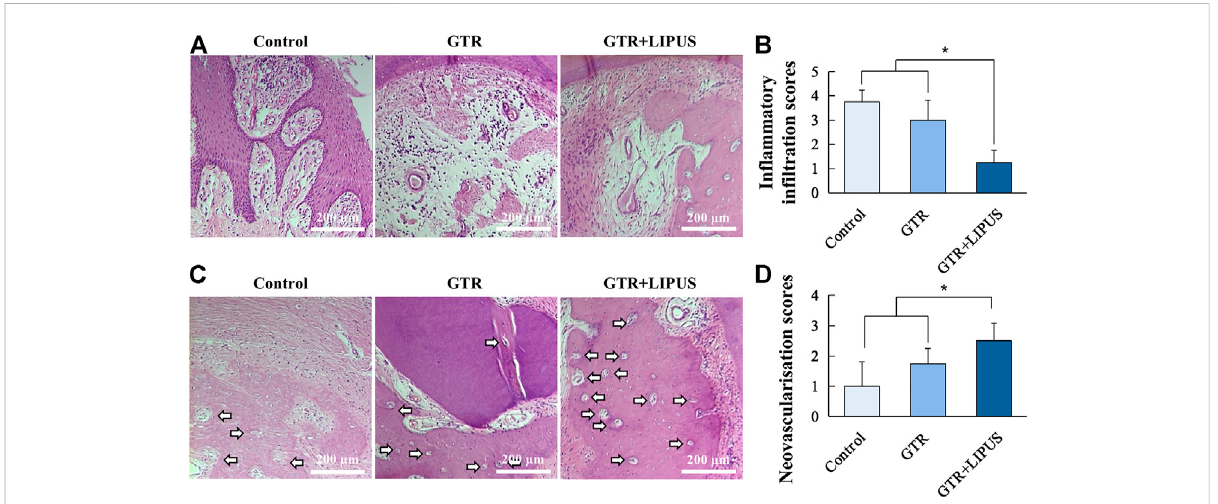
FIGURE 4 Histological assessment of in fl ammatory in fi ltration and neovascularization. (A) Lymphocyte in fi ltration of the control group, GTR group, and GTR+LIPUS group. Scale bar, 200 μ m. (B) In fl ammatory in fi ltration scores of different groups; * p < 0.05. (C) Blood vessels in the defect area are indicated by white arrows. Scale bar, 200 μ m. (D) Neovascularization scores of different groups; * p < 0.05.